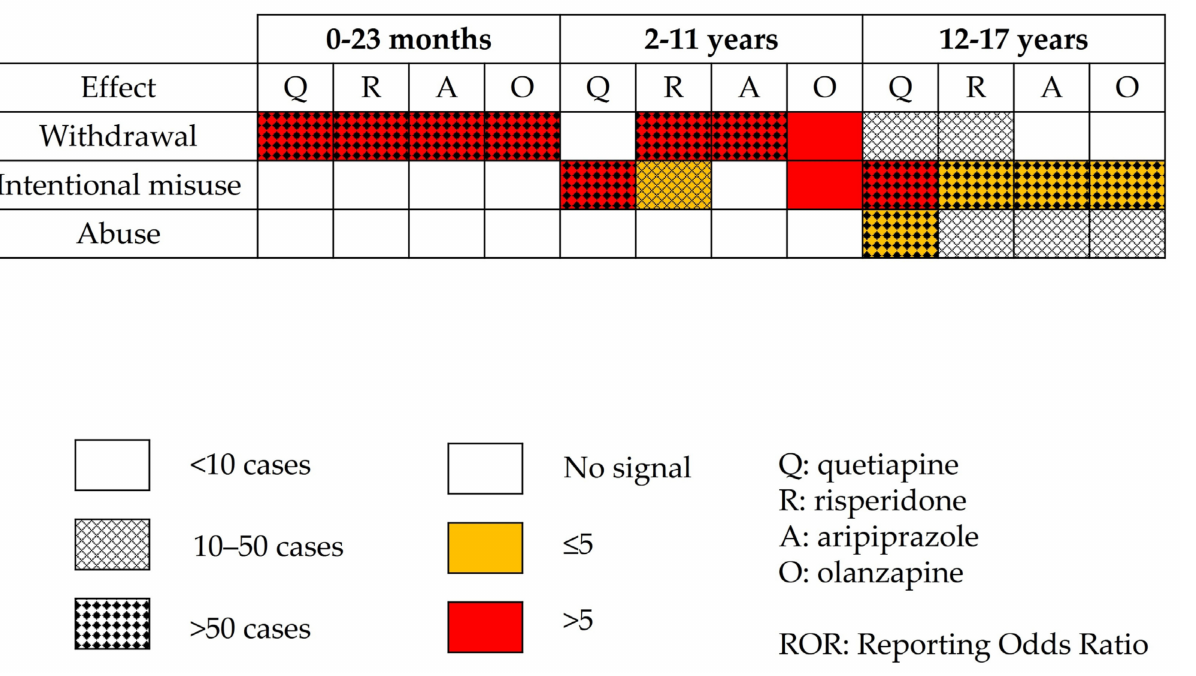
Figure 3. Disproportionality analysis using combined Preferred Terms for most involved